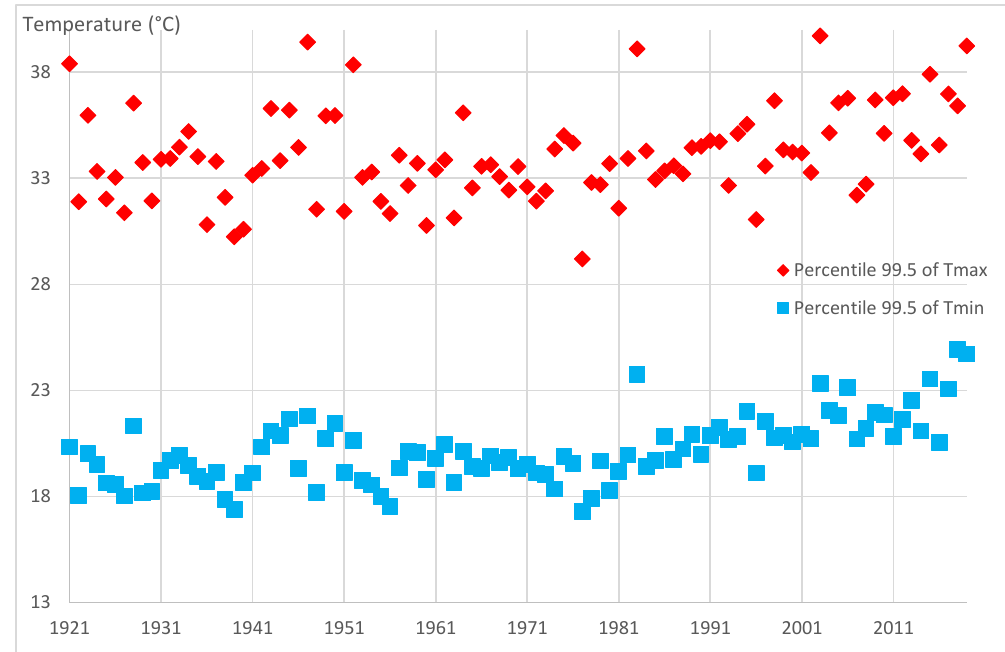
Figure 3. Evolution of the 99.5 percentiles of Tmax and Tmin over the period 1921 – 2019 (source: Météo-France).